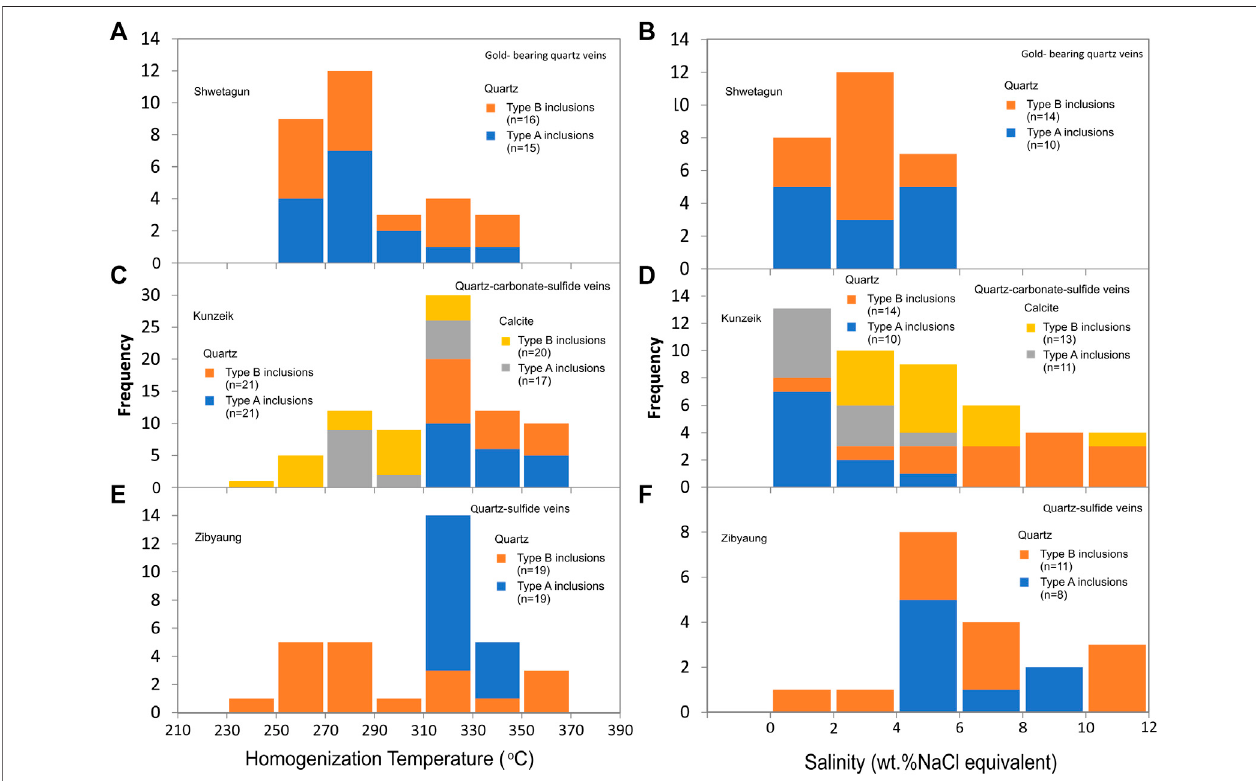
FIGURE 12 | Histograms of total homogenization temperatures (T h ) and salinities of primary fl uid inclusions in quartz, quartz-sul fi de and quartz-carbonate-sul fi de veinsfromthedeposits. (A) HistogramsofT h ofprimary fl uid inclusionsingold-bearingquartzveinsfrom theadit-I, IIandIII atShwetagun, (B) Salinities of fl uidinclusions in gold-bearing quartz veins from the adit-I, II and III at Shwetagun, (C) Histograms of T h of primary fl uid inclusions in quartz-carbonate-sul fi de veins from Kunzeik, (D) Salinitiesof fl uidinclusionsinquartz-carbonate-sul fi deveinsfromKunzeik, (E) HistogramsofT h ofprimary fl uidinclusionsinquartz-sul fi deveinsfromZibyaung,and (F) Salinities of fl uid inclusions in quartz-sul fi de veins from Zibyaung. Figures (C) , (D) , (E) and (F) are adapted from Myo Kyaw Hlaing et al. (2019). Abbreviations: n (cid:1) number of fl uid